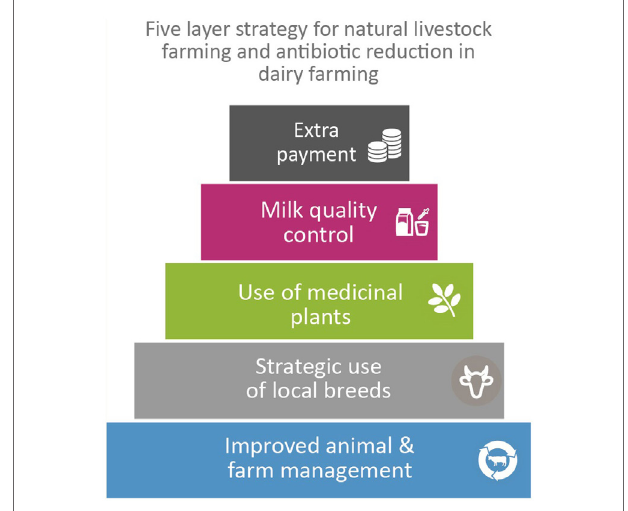
FiGUre 2 | the Natural Livestock Farming five-layered approach to reduce the use of antibiotics and other chemicals in dairy